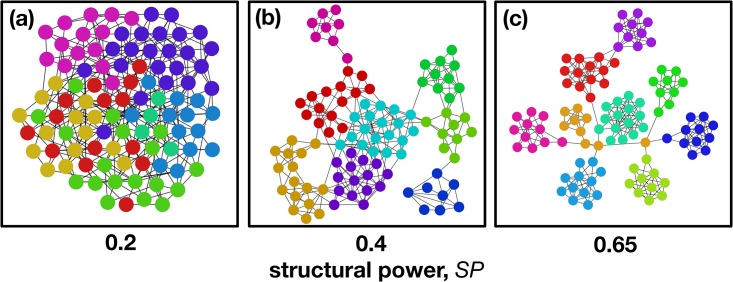
Intuitive representation of graphs with different average SP.The Fig provides an intuition for the effect of increasing SP in a small network of 100 nodes, while keeping the average degree, <k> = 6, constant. As the SP increases ((a) SP = 0.2, (b) SP = 0.4 and (c) SP = 0.65), different modular sub-structures increasingly appear. The disposition of nodes follows the Force Atlas algorithm [78] and the color scheme represents the detected communities by the Louvain method [78, 79].